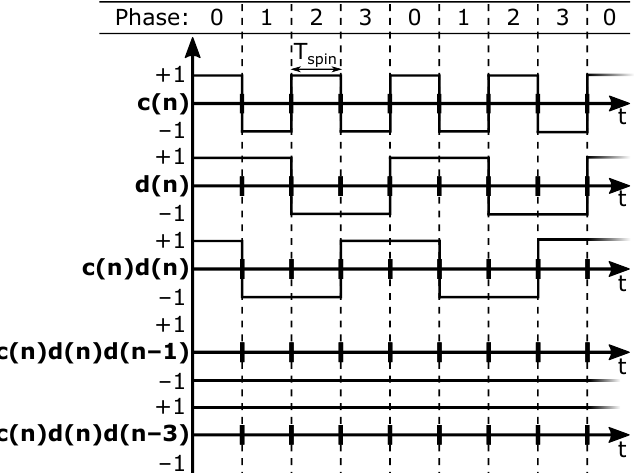
Figure 2. Modulation functions explaining the offset tones originating from classical four-phase spinning.